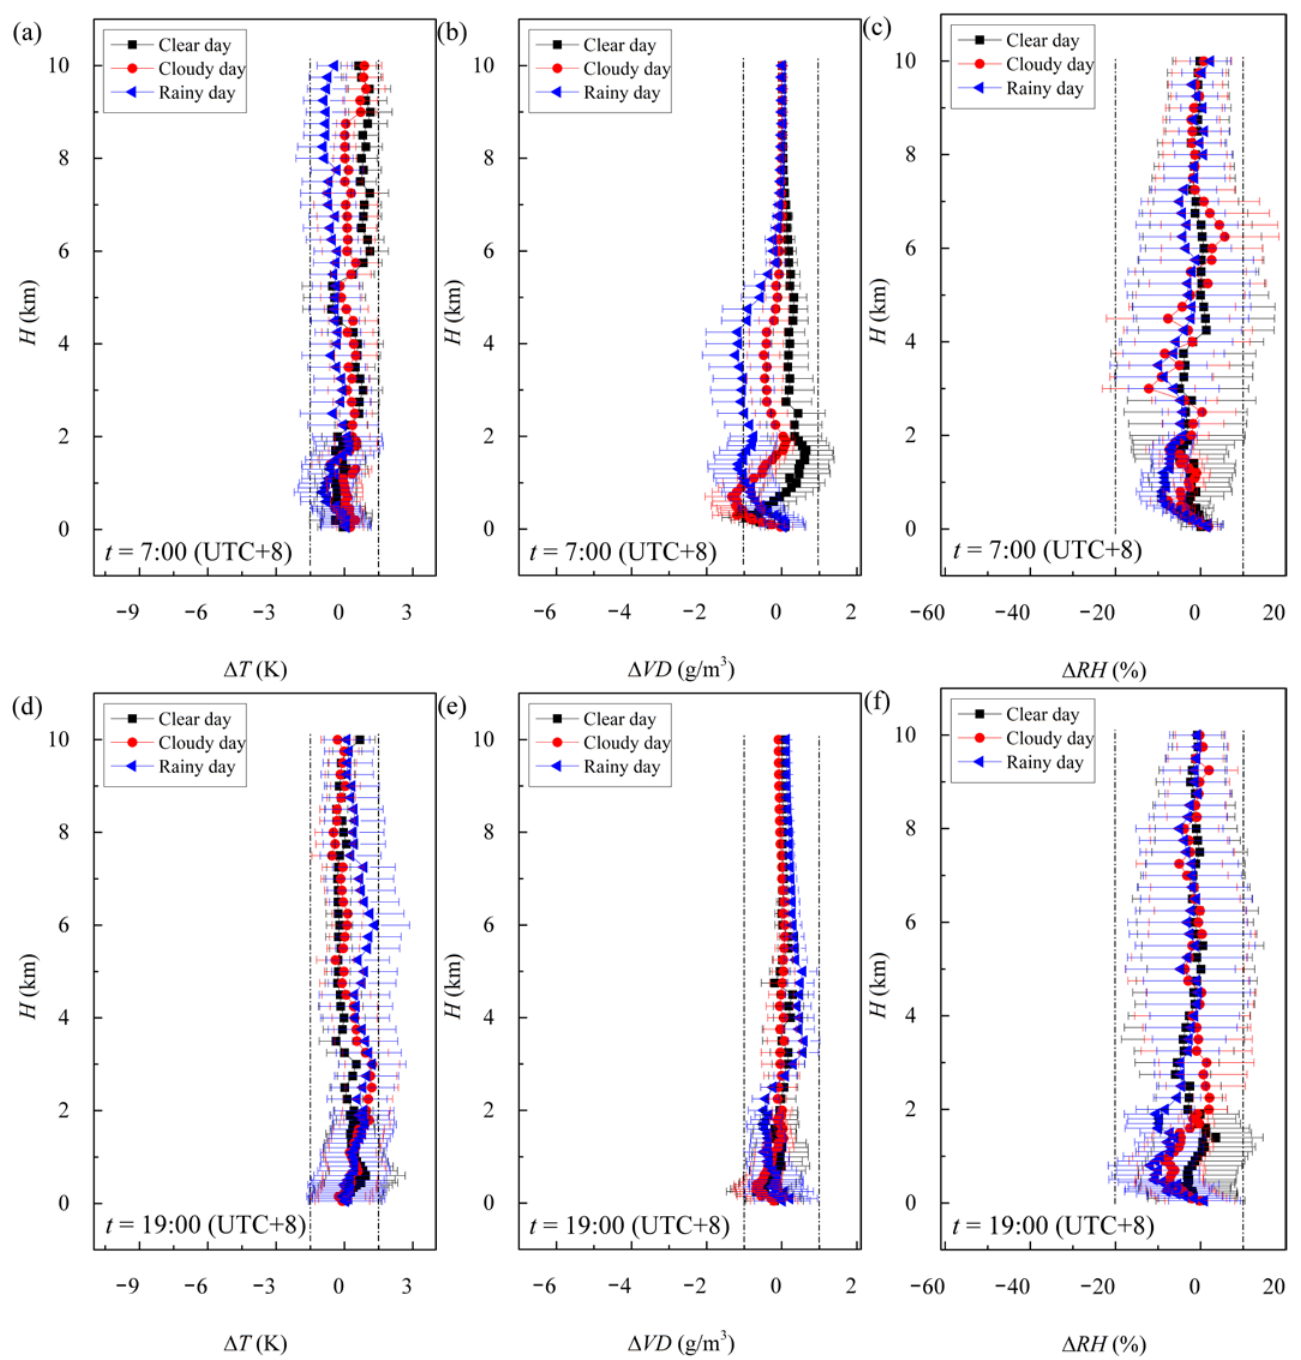
Figure 4. Comparison of temperature bias ( a , d ), vapor density bias ( b , e ), and relative humidity bias ( c , f ) profiles obtained from MWR and radiosonde observations under clear-sky, cloudy-sky, and rainy-sky conditions. Panels ( a – c ) and ( d – f ) denote retrieval parameters at 7:00 and 19:00, respectively. RMSEs are marked by error bars in ( a – f ).